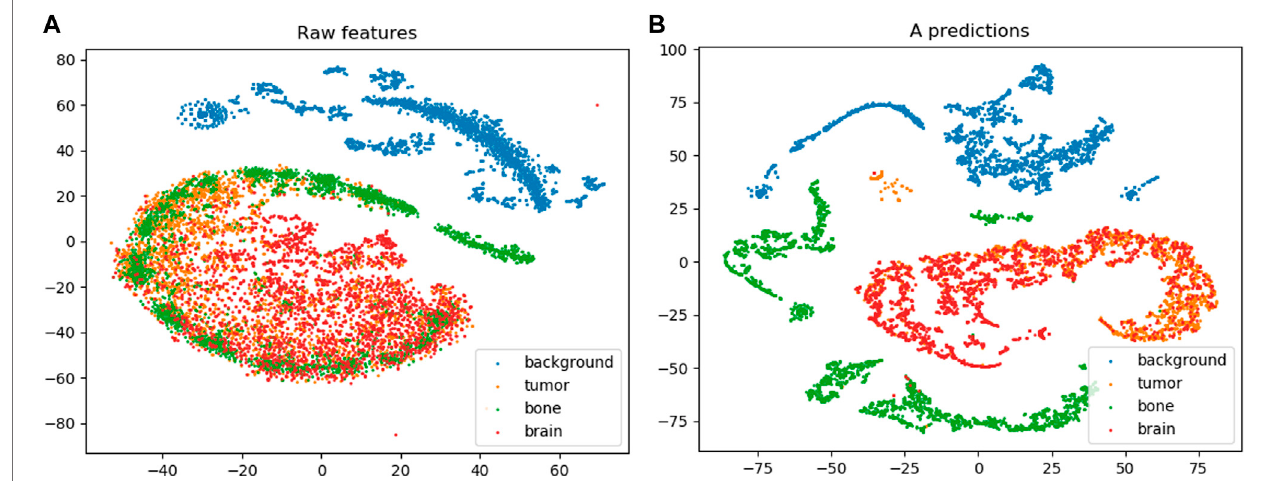
FIGURE8| The results from t-SNE embedding (van der Maaten and Hinton, 2008) on the raw feature set (A) and the learned M attribute predictions encoded in A (B) . Although some separation is apparent on the raw feature embedding, especially between less-correlated categories like bone and brain, the separation is far stronger on the M attribute embedding, and even separates similar categories like brain and tumor while maintaining perceptual distances. This shows that the MAC-CNN has effectively learned to distinguished categories of image patches using the M attributes.